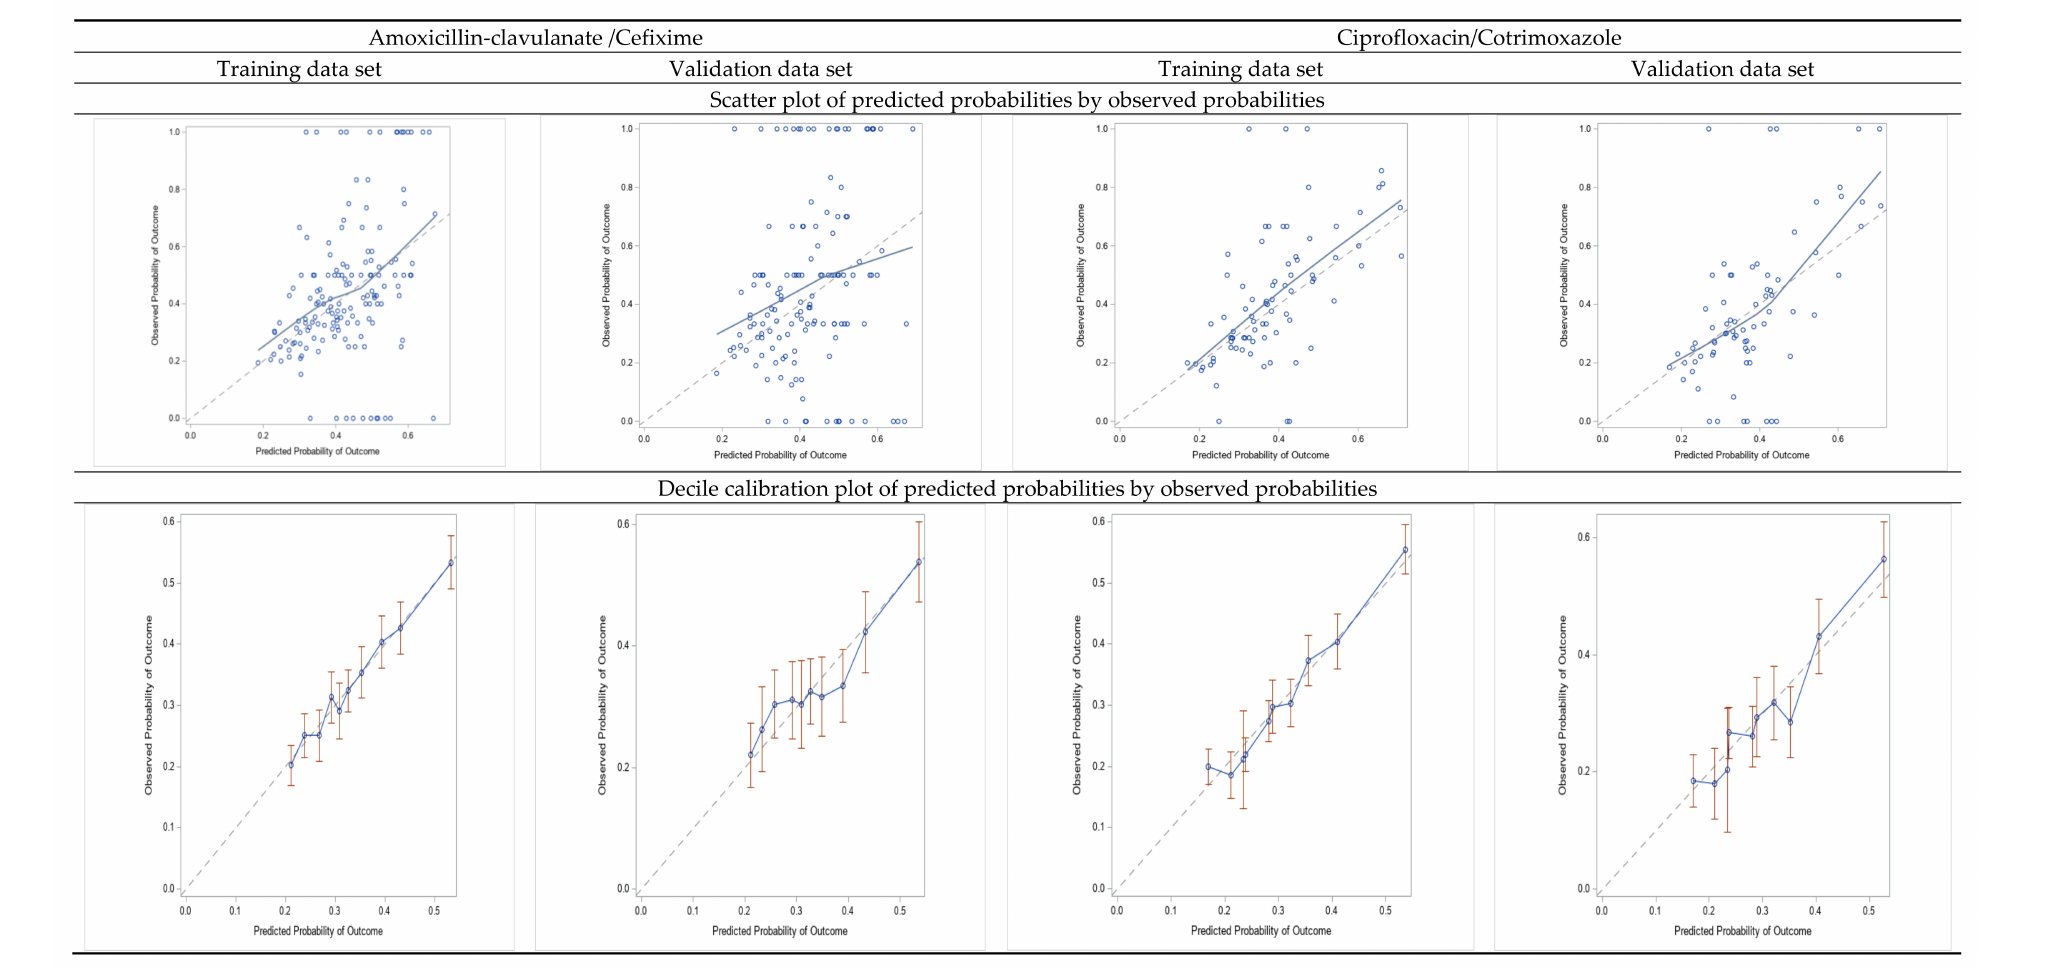
Figure 3. Calibration plots: scatter plots of predicted probabilities by observed probabilities of resistance, and decile calibration plots for the training and validation data